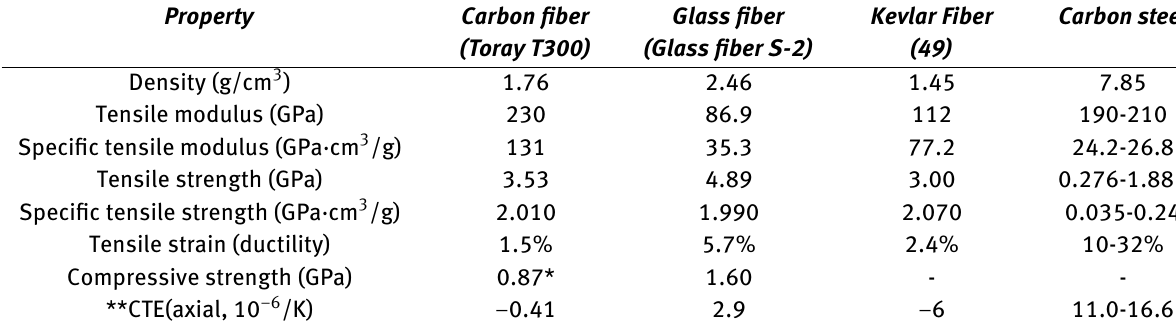
Table 2: Carbon fiber basic properties and comparison of carbon fiber, glass fiber, and Kevlar fiber, and carbon steel [30] Property